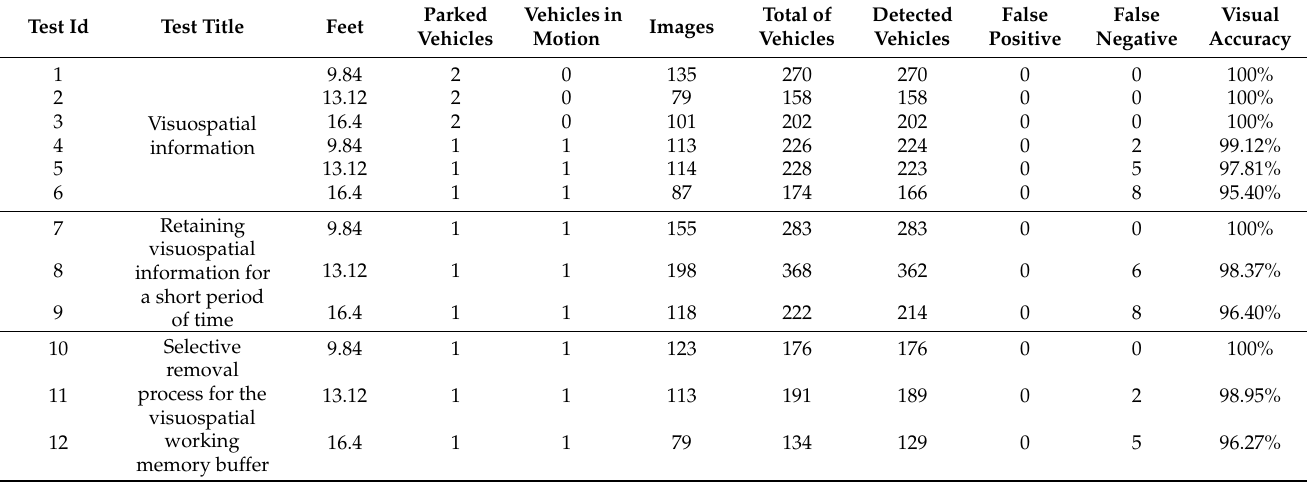
Table 5. Results of the first test